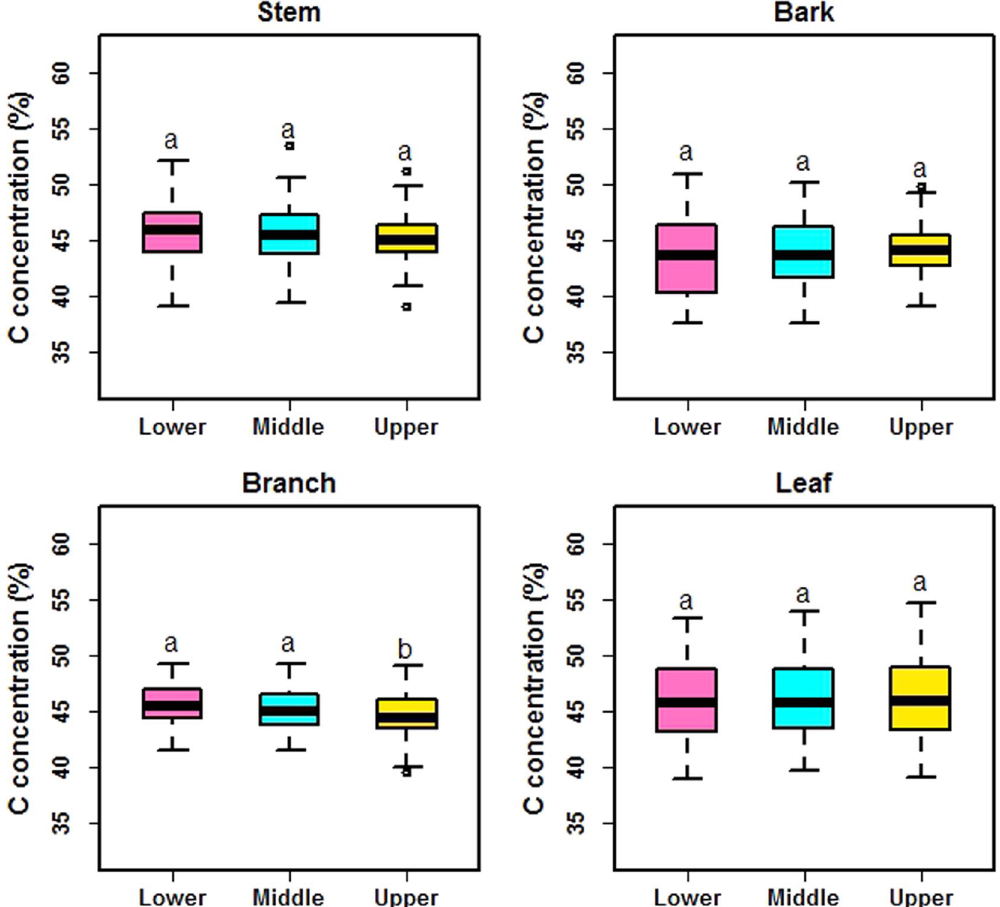
Figure 1. Effects of position on C concentrations in stems, bark, branches and leaves across all tree species. Lower, middle and upper for stem and bark refer to 0–1.3 m height, 1.3 m to half of total height and above half of total height of stem, respectively. Lower, middle and upper for branch and leaf refers to the position within the canopy. For the boxplots: circles are outliers; vertical bars are data ranges defined as 1.5 × the inter-quartile range; horizontal lines within the boxes are median values; and the upper and lower bounds of the boxes are the third and first quartiles, respectively. Letters indicate significant difference at P < 0.05 (n =